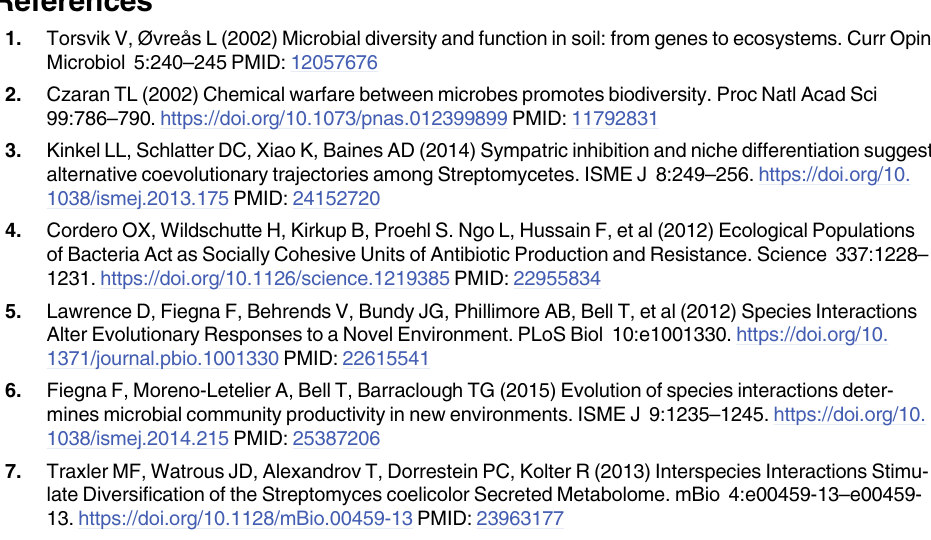
S2 Table. Interaction matrix among Streptomyces isolates for communities A, B, and C. Ones represent inhibitory phenotypes of the isolates in the row against isolates in the columns.